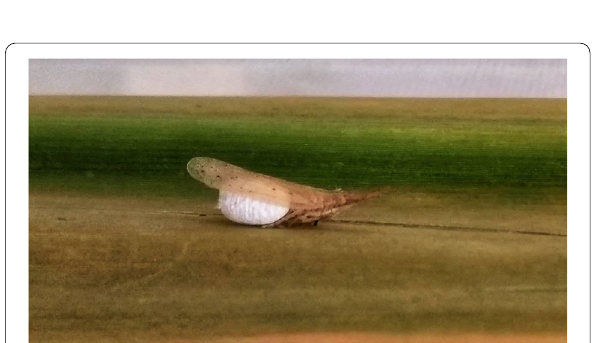
Fig. 6 Parasitized adult of sugarcane